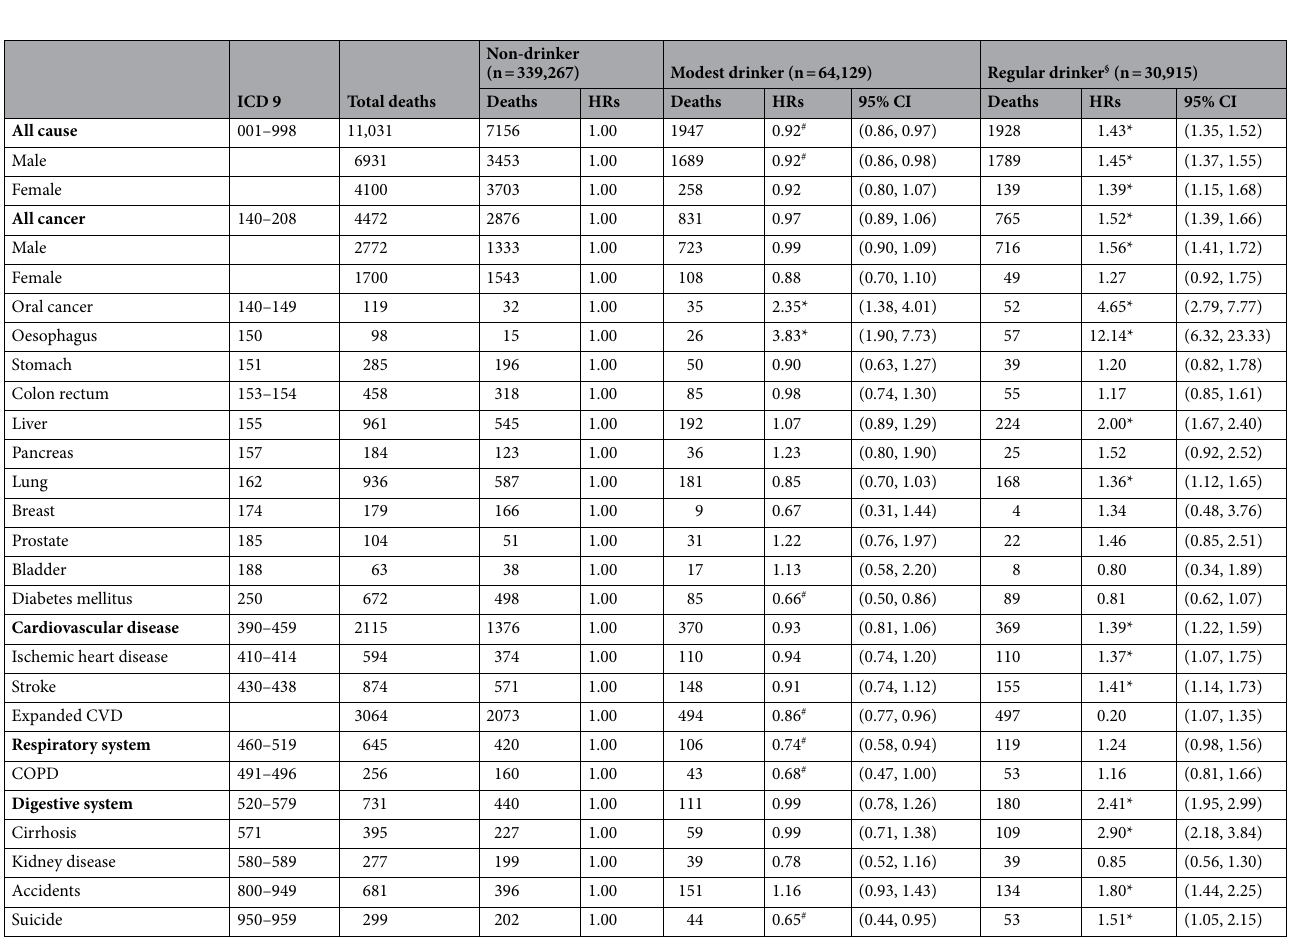
Table 2. Mortality risks by alcohol drinking status, compared to non-drinker. Hazard ratios are adjusted for age, gender, education, body mass index, smoking, physical activity, systolic blood pressure, fasting blood glucose, anemia, total cholesterol, high-density lipoprotein cholesterol, low-density lipoprotein cholesterol, triglycerides, proteinuria, uric acid level and C-reactive protein in a multivariate Cox model when appropriate. Expanded CVD CVD plus diabetes plus kidney disease. # Indicates that the statistically significant reduction in HRs. *Indicates a statistically significant increase in HR. § Regular Drinker include ex-drinker